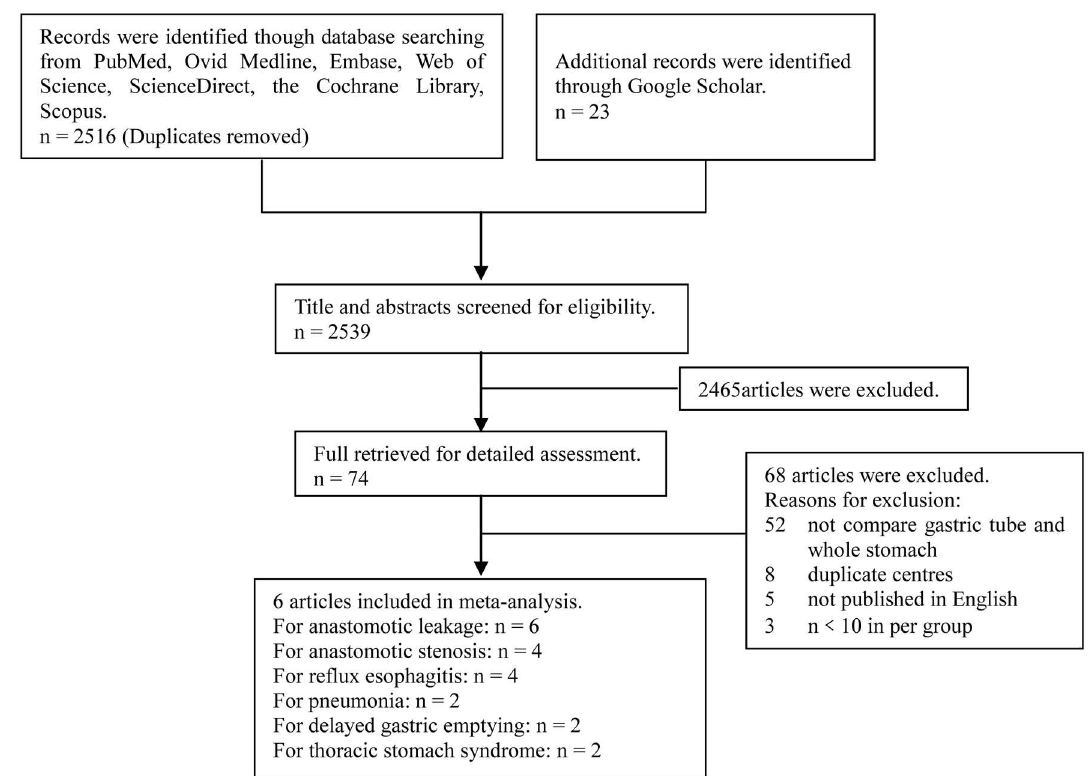
Fig 1. Flow diagram of study selection.